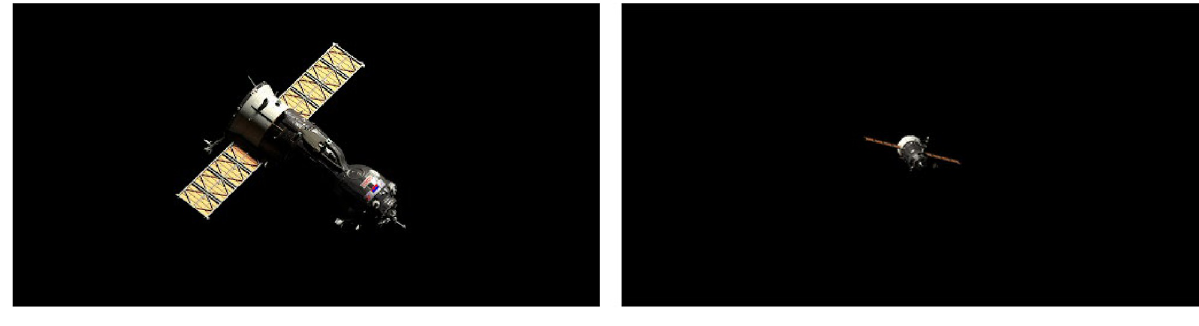
Fig 12. Rendering of a spacecraft